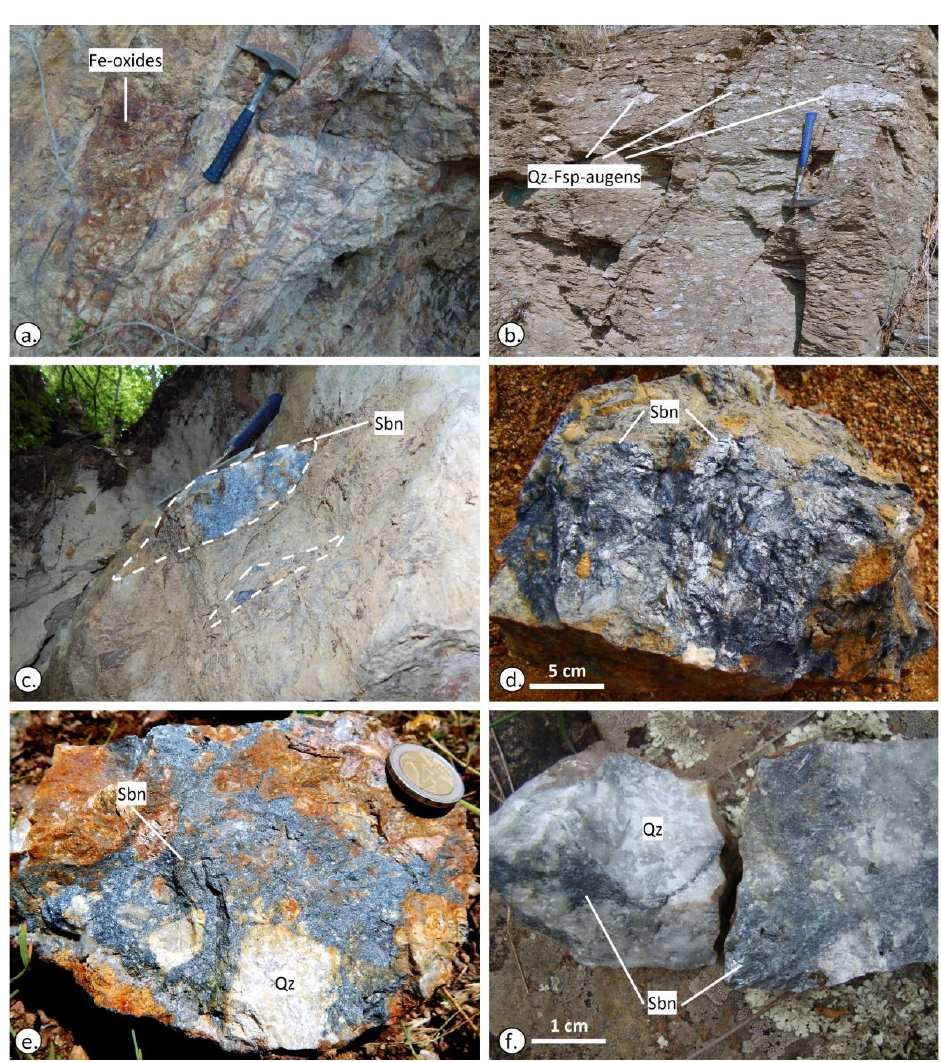
Figure 3. Field photographs of the local lithology and the stibnite mineralization: ( a ) Fe – oxides in the two-mica gneiss; ( b ) Augen-gneiss outcrop with numerous quartz (Qtz) – feldspar (Fsp) – augens of various sizes along the foliation; ( c ) Dashed lines outline two discordant lodes of stibnite (Sbn) mineralization; ( d ) Massive and granular stibnite (Sbn) mineralization; ( e ) Massive (Sbn) cements brecciated quartz; ( f ) Fragments of a quartz – stibnite vein where stibnite (Sbn) fills spaces along quartz clusters (Photo courtesy: Vasilios Melfos).